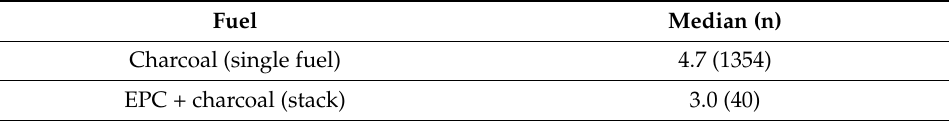
Table 14. Per capita charcoal energy consumption (MJ/event/person) (Phase